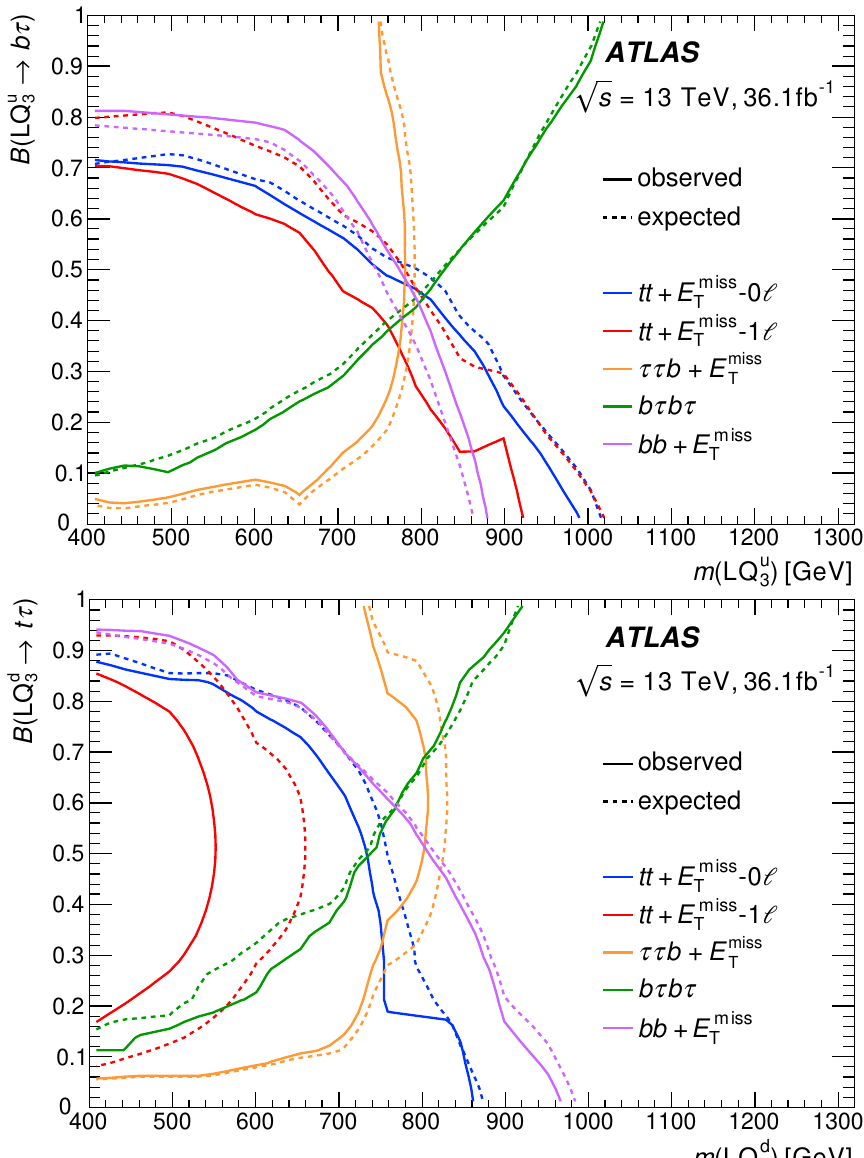
Figure 17 . Limits on the branching ratio into charged leptons for scalar third-generation up-type (upper panel) leptoquark pair production (LQ u ! b(cid:28)=t(cid:23) ) and down-type (lower panel) leptoquark 3 pair production (LQ d ! t(cid:28)=b(cid:23) ) as a function of the leptoquark mass. The limits are based on a 3 dedicated LQ search for two b -jets and two (cid:28) -leptons ( b(cid:28)b(cid:28) ), and reinterpretations of the search for bottom-squark pair production ( bb + E miss ) [24], for top-squark pair production with one T ( tt + E miss -1 ‘ ) [22] or zero leptons ( tt + E miss -0 ‘ ) [23] in the (cid:12)nal state, and for top squarks decaying T T via (cid:28) -sleptons ( (cid:28)(cid:28)b + E miss ) [25]. The region to the left of the contour lines is excluded at 95% T con(cid:12)dence